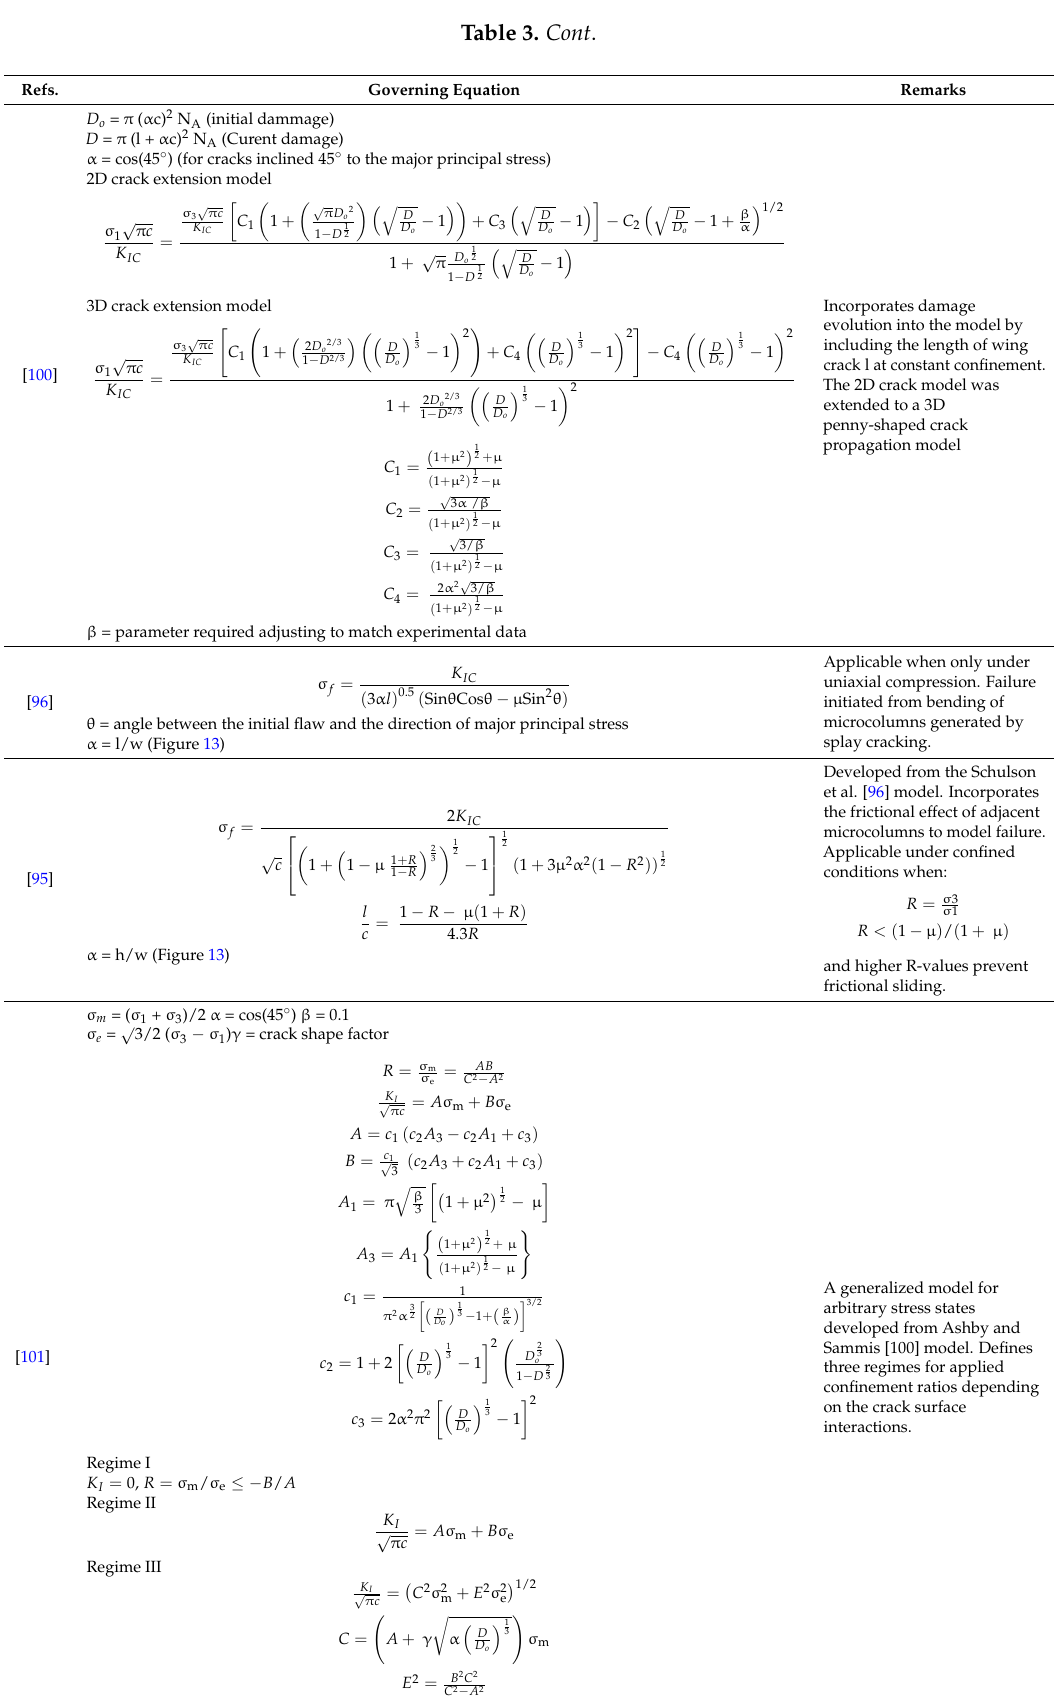
Incorporates damage evolution into the model by